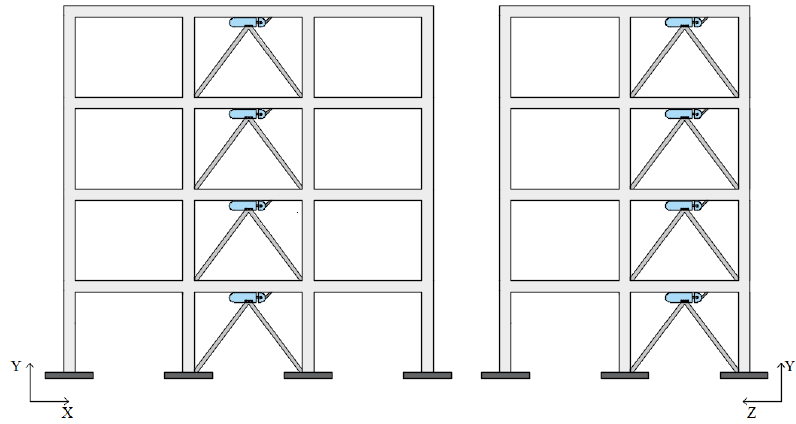
Figure 13. Elevation layout of Chevron braces equipped with the PS-LED in the RC case-study structure.